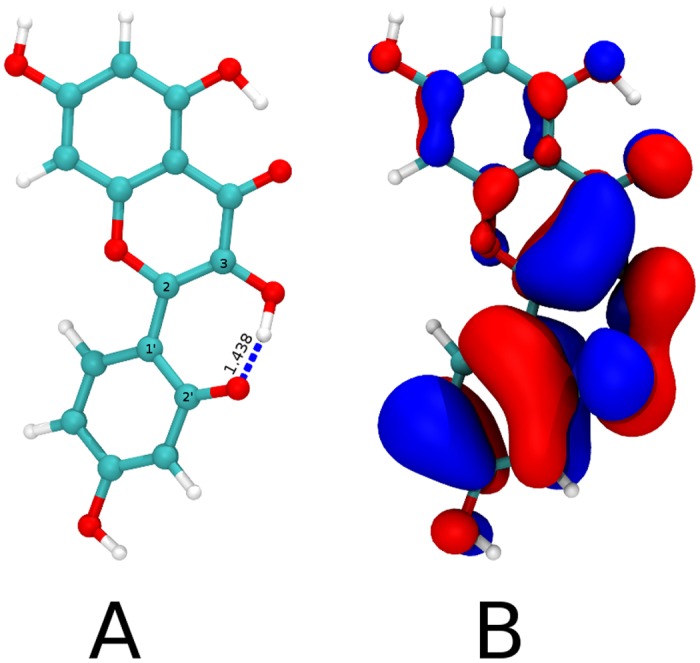
Morin deprotonated.Panel A shows the optimized geometry for morin deprotonated at 2’-OH at the DFT B3LYP/6-311++G** level with a dihedral angle C3-C2-C1’-C2’ equal to 27.6° and highlights the hydrogen bond between 3OH and 2’-O- (1.438 Å, blue dashed line). White, cyan and red represent Hydrogen, Carbon and Oxygen atoms respectively. Panel B depicts the HOMO for the geometry in panel A (isovalue 0.02 a.u) showing large and localized electron density over the enol.